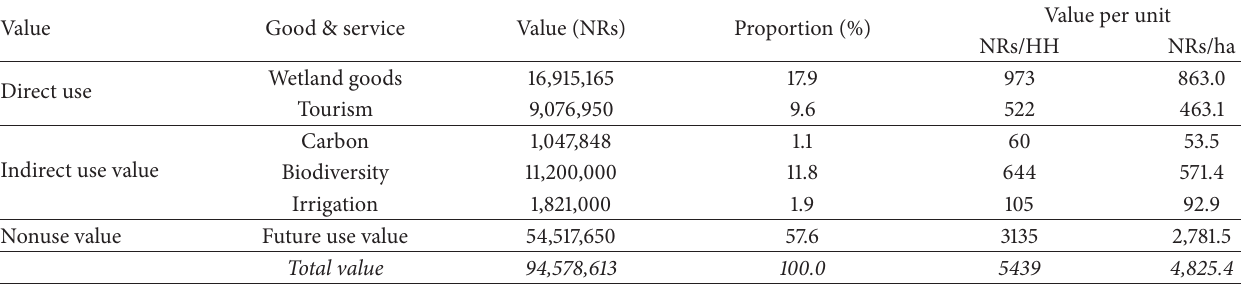
Table 12: Total economic value of goods and